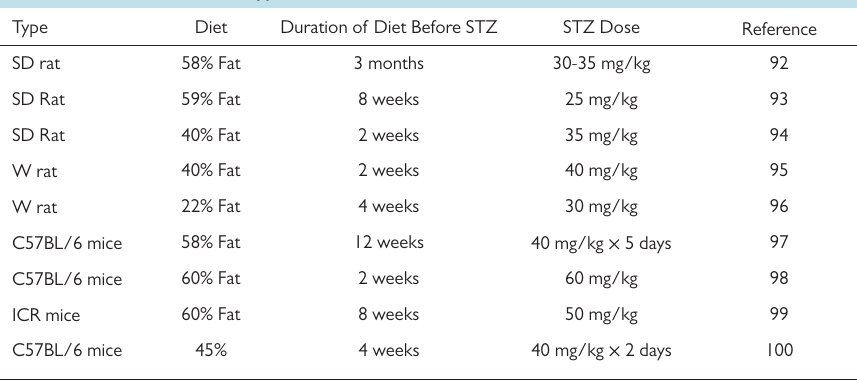
Table 7. HFD/STZ-Induced Type 2 Diabetes Model in Rats and Mice